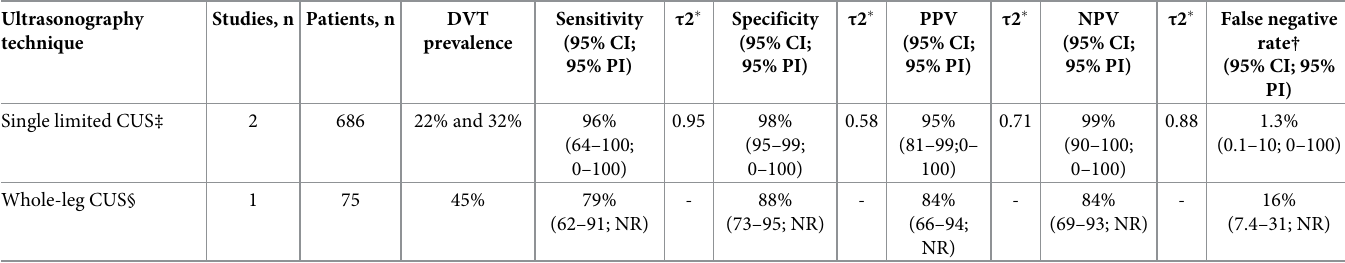
Table 2. Summary estimates diagnostic accuracy of compression ultrasonography in studies that used contrast venography as a reference standard. Ultrasonography